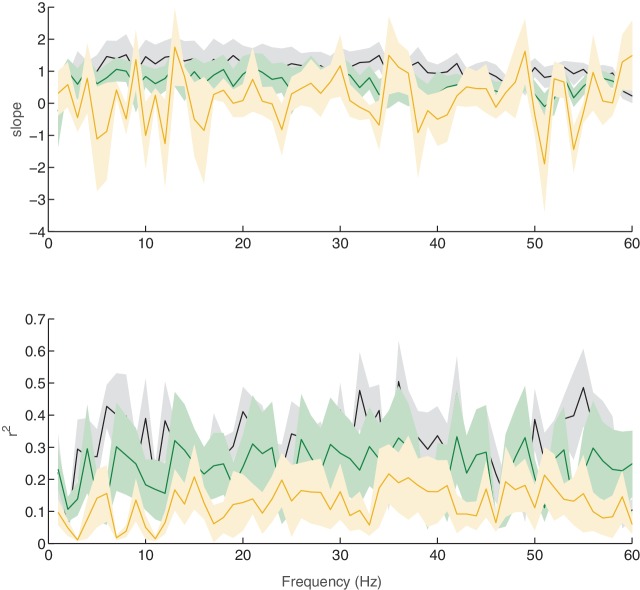
Linear relationship between SERR and coherence across different frequencies for control sessions.Replication of Figure 4H for control (no stimulation) sessions. Each line shows the mean and standard error (shaded region) of regression slope and r2 as a function of the coherence frequency.10.7554/eLife.31034.011Figure 4—figure supplement 1—source code 1.SERR and coherence relationship across different frequencies for control sessions.10.7554/eLife.31034.012Figure 4—figure supplement 1—source data 1.SERR and coherence measurements acrossdifferent frequencies and channels for control sessions.